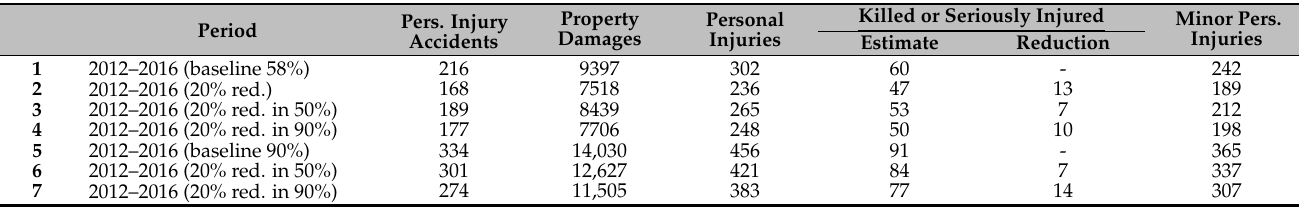
Table 7. Averages for accidents involving personal injuries and property damage per year during the period 2012–2016. Calculation example of 20% reduction in personal injury accidents due to fleet management system. Rows 1–4 include trucking companies (58% of HGV km), while Rows 5–7 also include companies involved in transport for own account (90% of HGV